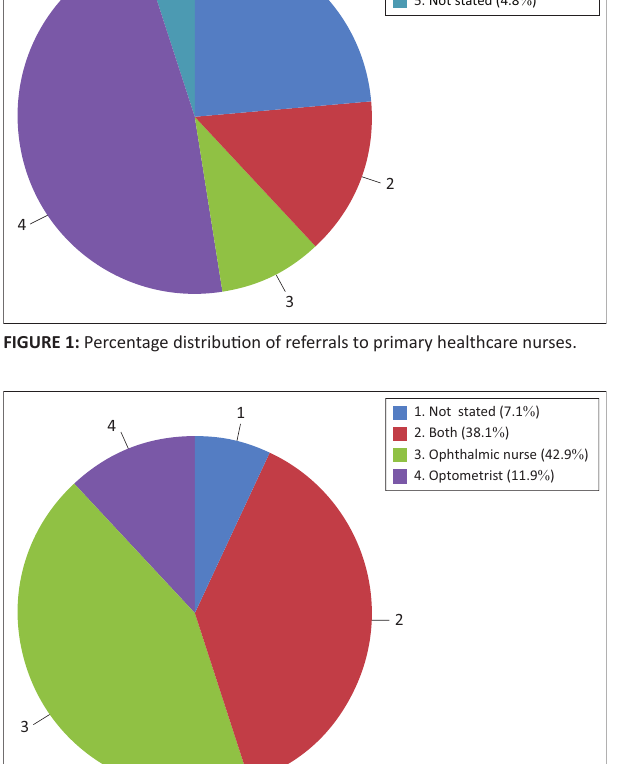
FIGURE 2: Percentage referrals from primary healthcare nurses to ophthalmic nurses and optometrists.